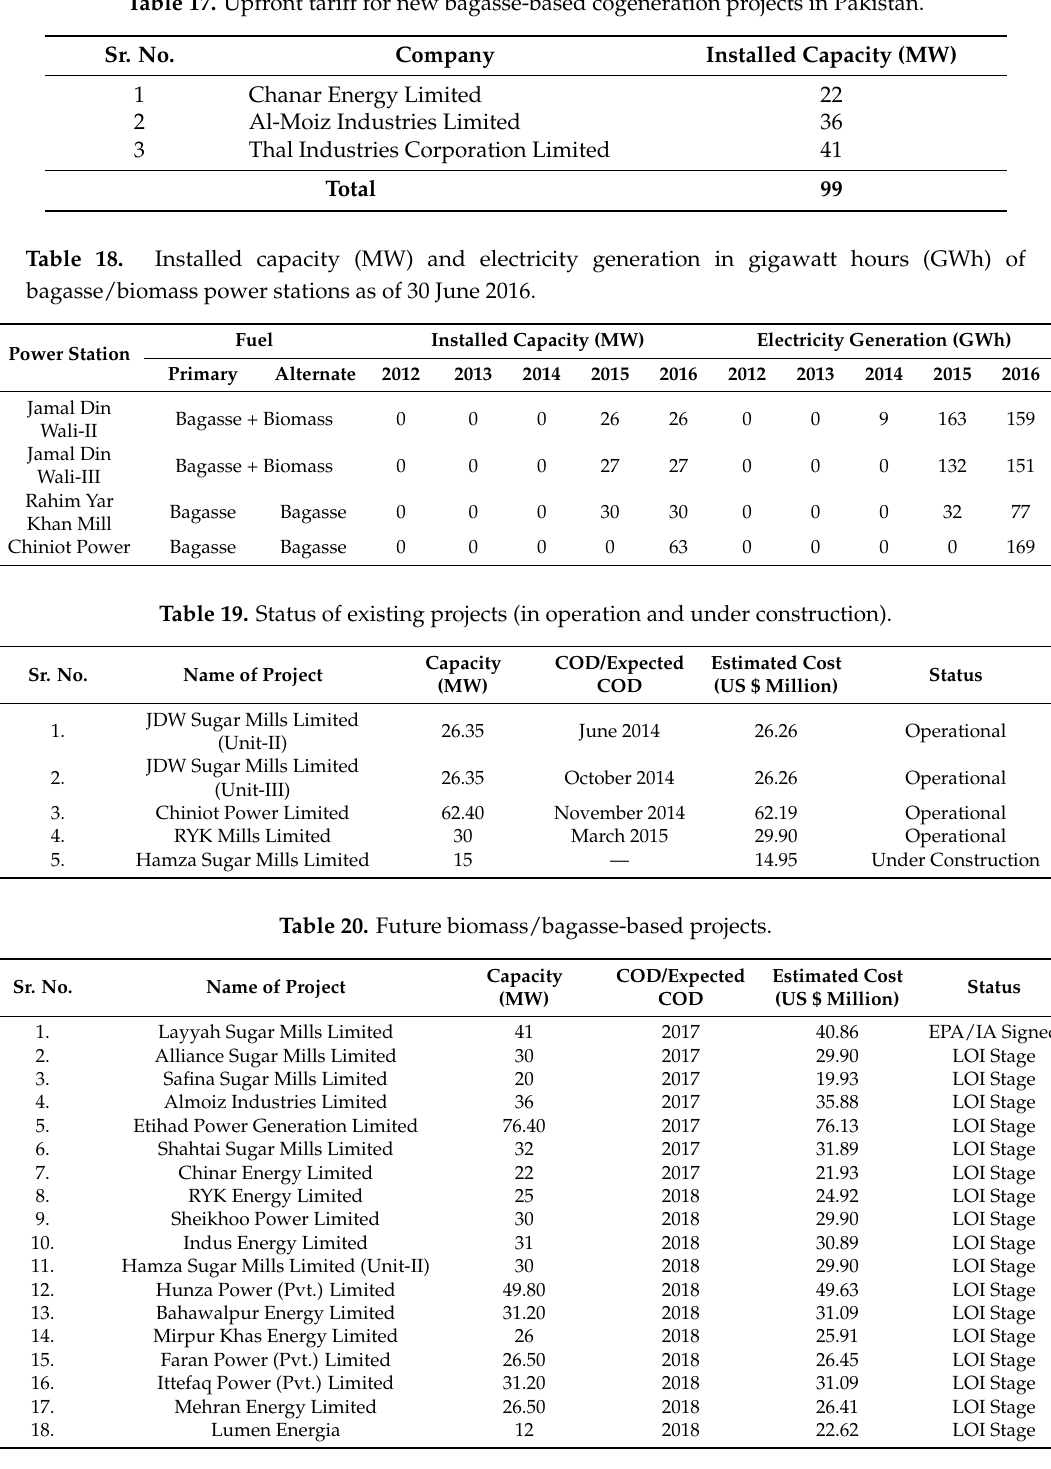
Table 17. Upfront tariff for new bagasse-based cogeneration projects in Pakistan.